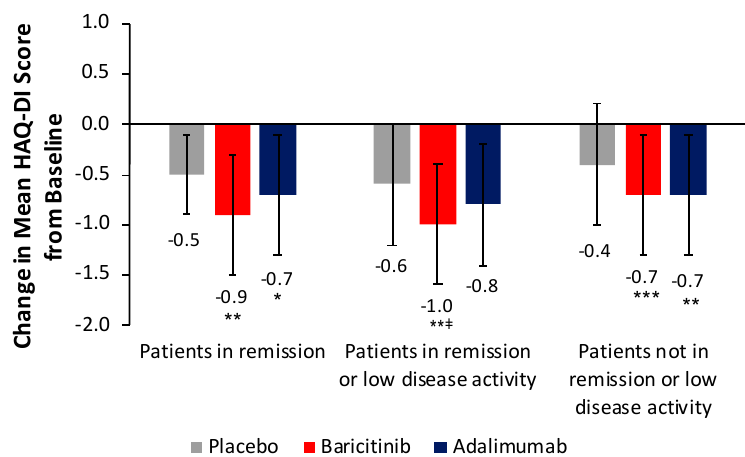
Figure 2. Change from baseline in HAQ-DI score at week 24 by remission status in patients from RA-BEAM. * p < 0.05, ** p < 0.01, *** p < 0.001 vs. placebo; ‡ p < 0.05 vs. adalimumab. Error bars indicate standard deviation. Change in HAQ-DI score based on numbers of patients from RA-BEAM in remission (DAS28-ESR < 2.6): PBO + MTX n = 24, BARI + MTX n = 87, ADA + MTX n = 57; in remission or low disease activity (DAS28-ESR ≥ 2.6 and ≤ 3.2): PBO + MTX n = 46, BARI + MTX n = 154, ADA + MTX n = 110; and not in remission or low disease activity: PBO + MTX n = 276, BARI + MTX n = 266, ADA + MTX n = 156. One patient was missing from the BARI + MTX group and one from the ADA + MTX group for patients not in remission or low disease activity. ADA adalimumab, BARI baricitinib, DAS28-ESR